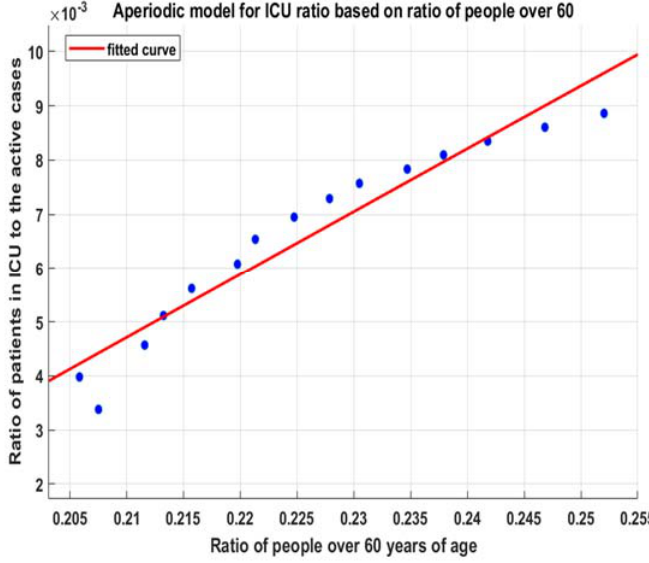
Figure 7. Fitted model (9) for hospitalizations.